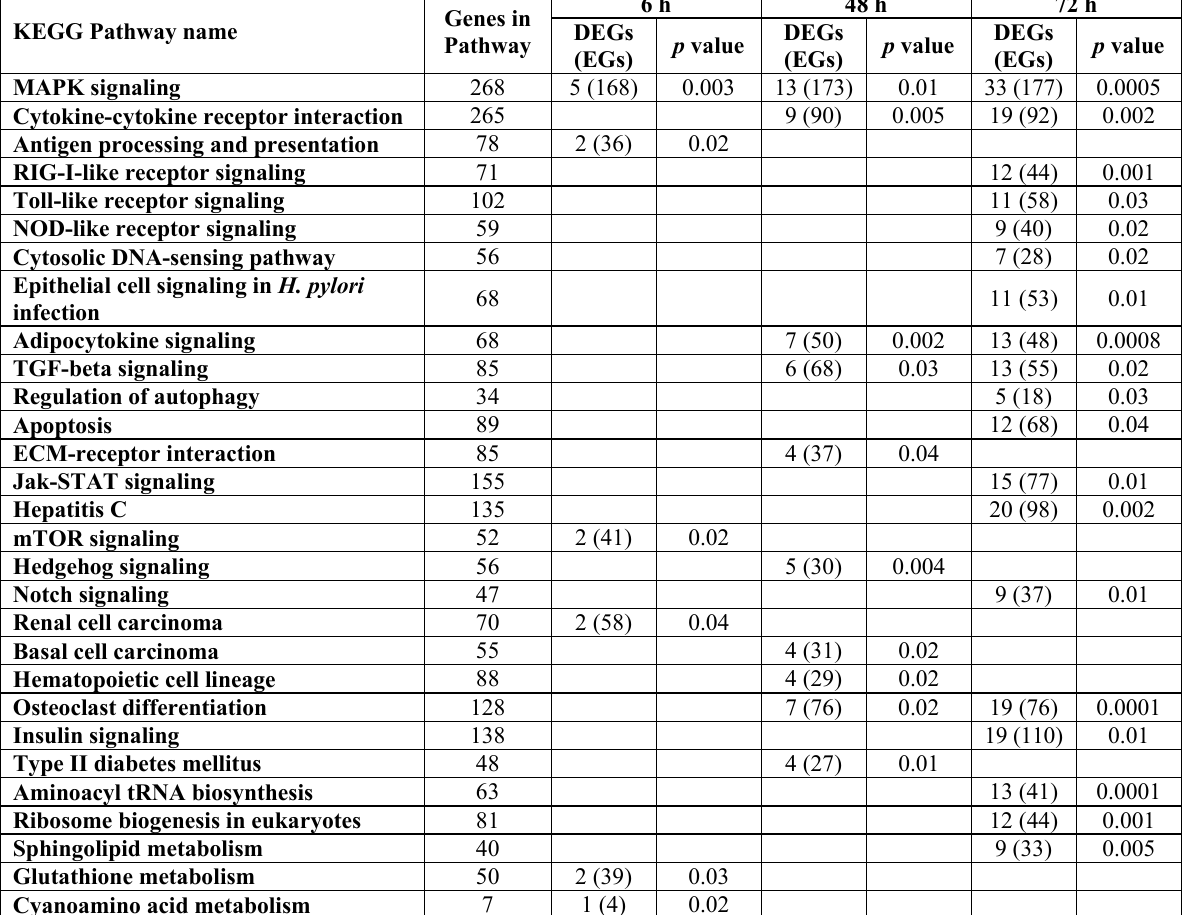
Table 3. Enriched Kegg pathways during acute HCV infection. Differentially